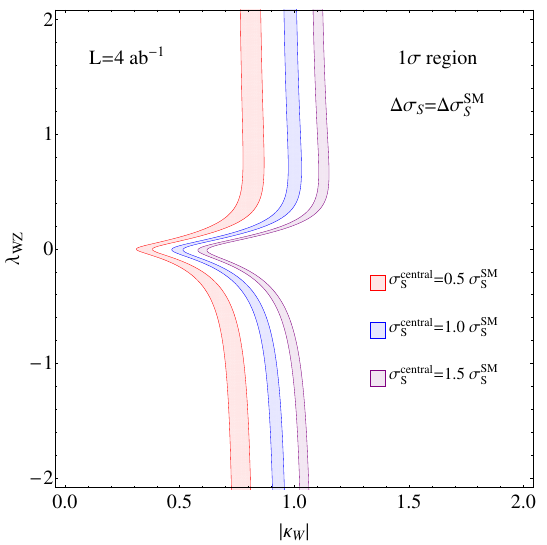
Figure 8 . 1 (cid:27) regions in the (cid:20) W - (cid:21) WZ plane when the measured signal cross section has the central j j (cid:27) SM value (cid:27) central = (0 : 5 ; 1 ; 1 : 5) and an error bar assumed to be the same as the SM expectation, S S (cid:2) assuming the 500 GeV ILC with the beam polarization P ( e (cid:0) ; e + ) = ( luminosity of 4 ab (cid:0) 1